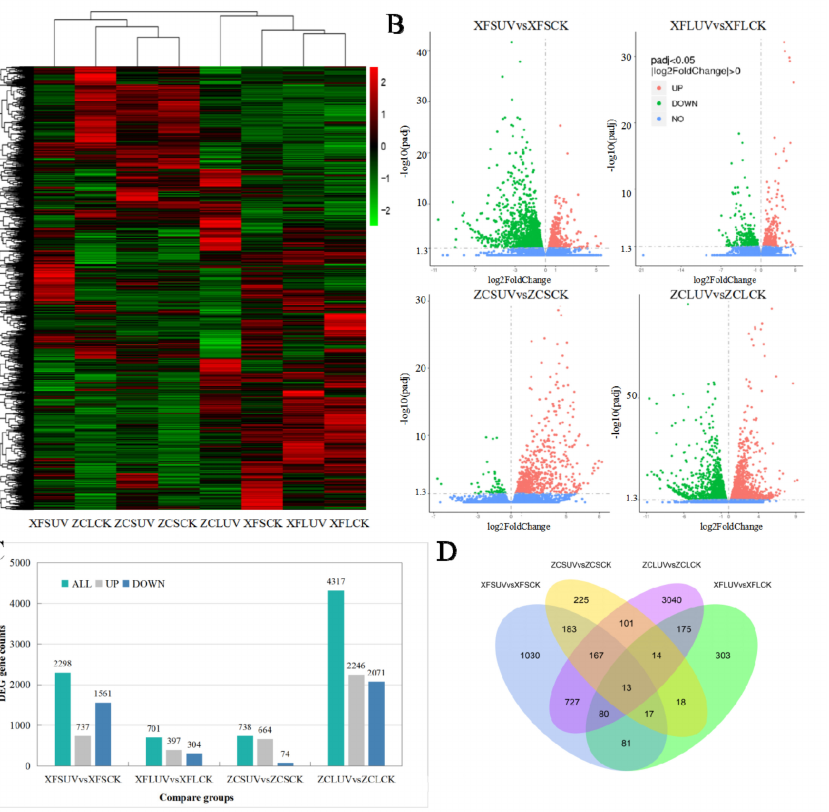
Figure 2. Differentially expressed genes (DEGs) of different compare groups. ( A ) Comparison of the transcription level of DEGs. ( B ) Volcano map for the significance level of the DEGs. The horizontal axis represents the fold change of DEGs, and the vertical axis represents the significance level of the difference. Padj indicates the corrected p value after the multiple hypothesis test, the same as below. ( C ) Comparison of the DEG numbers in different comparison groups. ( D ) The number of shared or specific DEGs between different comparison groups. XFSUV/XFSCK indicates ‘Xiangfei’ under short-term UV-C/control conditions. XFLUV/XFLCK indicates ‘Xiangfei’ under long-term UV- C/control conditions. ZCSUV/ZCSCK indicates ‘Zicui’ under short-term UV-C/control conditions. ZCLUV/ZCLCK means ‘Zicui’ under long-term UV-C/control condition vs. means the change of the former relative to the latter. The same as